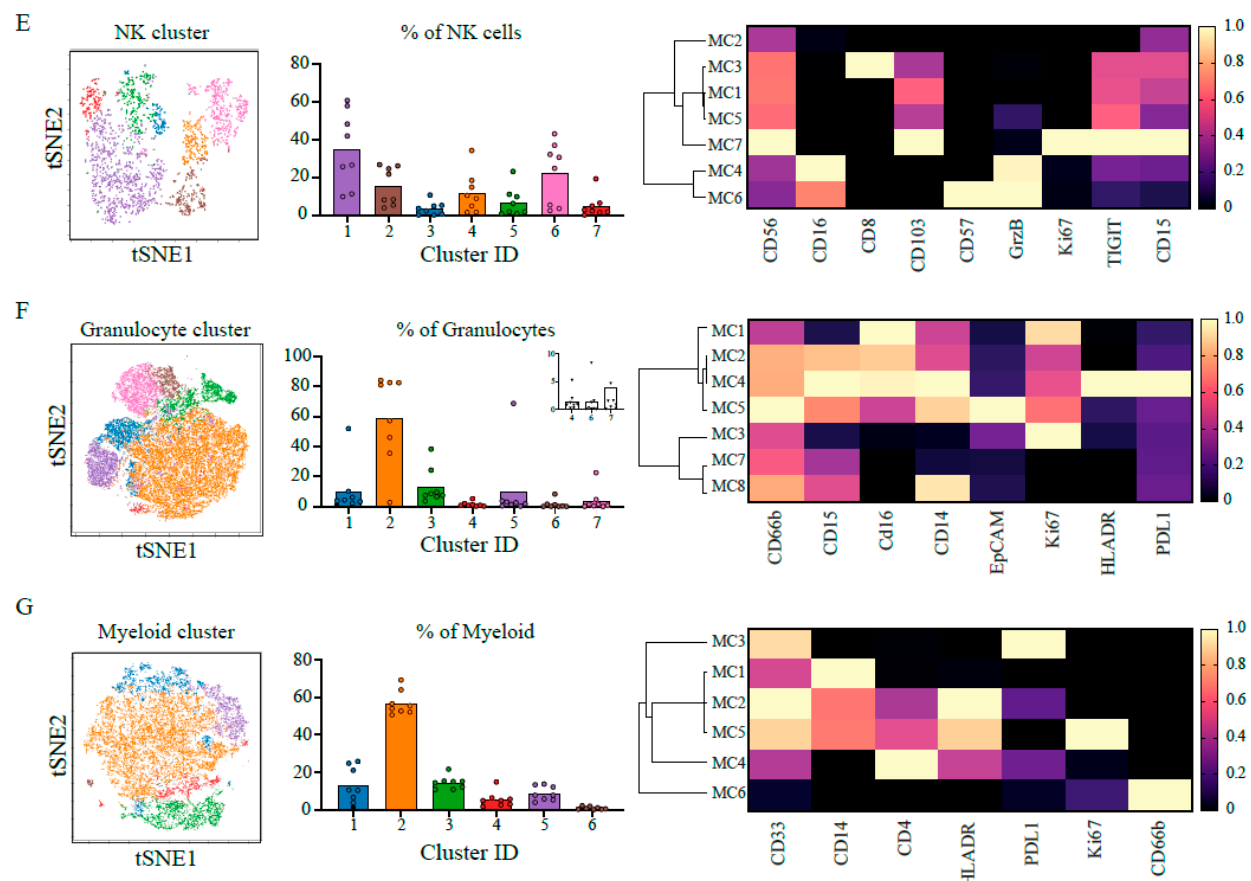
Figure 1. Immune infiltration into PDAC is heterogenous but with a marked T-cell population. ( A ) Schematics of the experimental procedure; primary resectable pancreatic tumours are made into single-cell suspensions and taken for phenotyping using mass cytometry (CyTOF). CyTOF data was clustered using cytobank FlowSOM to identify common populations across patients. Using a set of lineage markers, checkpoints and activation markers cellular states and functionality are defined with a focus on T-cell populations. ( B ) 200,000 cells pooled from 8 patients were gated in silico and cellular granularity was assessed; Immune cells (CD45 + ), epithelial cells (EpCAM + ), Stroma (CD45 - EpCAM − ) and EpCAM + Immune cells (CD45 + EpCAM + ). ( C ) 100,000 CD45 + cells pooled from 8 patients and viSNE analysis using main cell lineage markers was performed to identify the main immune cell populations. viSNE plot is shown with manual annotation of cell identities (top), expression profile of the CyTOF markers used for clustering is shown (bottom). ( D ) viSNE plot of the main immune populations coloured and labelled by FlowSOM. Bar plots of metacluster frequencies in each patient. Inset shows the B-cell and NK clusters (CV % 111.3 and 108.6% respectively). Heatmap of FlowSOM metaclusters of CD45 + cells; rows represent metaclusters from combined single cells across patients. ( E ) NK cells were clustered with FlowSOM and 7 different metaclusters identified. Metacluster’s relative frequency is presented in the bar plot. Inset shows the lower frequency metaclusters. Expression profile for each metacluster is shown in the heatmap (right). The major metacluster being a CD8 + NK population. ( F ) Granulocyte were clustered with FlowSOM and 7 different metaclusters identified. Metacluster’s relative frequency is presented in the bar plot. Inset shows the lower frequency metaclusters. Expression profile for each metacluster is shown in the heatmap (right). The major metacluster expressing an intermediate level of CD16 and CD15. ( G ) Myeloid cells were clustered with FlowSOM and 6 different metaclusters identified. Metacluster’s relative frequency is presented in the bar plot. Inset shows the lower frequency metaclusters. Expression profile for each metacluster is shown in the heatmap (right). The major metacluster expressing an intermediate level of CD14 and CD33 but high for MHCII (HLA-DR), and another important metacluster is the one lacking HLA-DR expression (MSDC). All bar plots are median and the individual dots are individual patients. Heatmaps are normalised for each marker with lowest expression marked in dark blue as zero, and highest in yellow as 1. MC= metacluster.